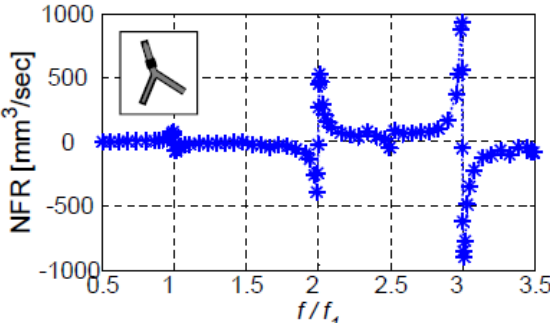
Figure 5. The dependence of NFR on the normalized actuation frequency for configuration III-a. The frequency is normalized by the first fundamental frequency of III-a, f 1 = 3.25 Hz. The actuator was located on the first vessel at X C / L 1 = 0.75. Bioengineering 2018 , 5 , x FOR PEER REVIEW